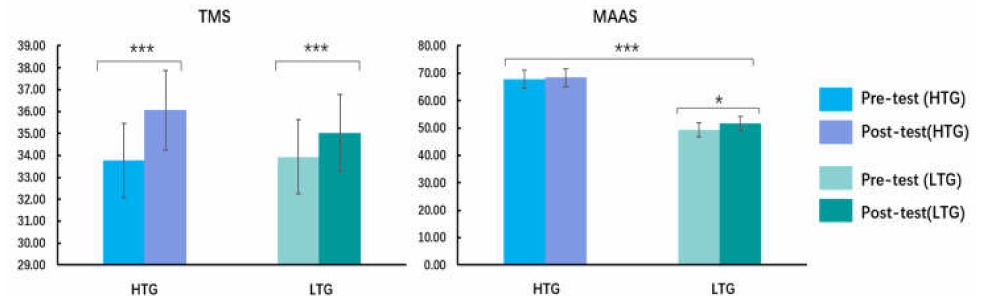
Figure 2. Toronto Mindfulness Scale (TMS) difference within-group and Mindful Attention Aware- ness Scale (MAAS) difference between-group before and after mindfulness meditation training. HTG: high trait group, LTG: low trait group; * p < 0.05, *** p < 0.001. No significant between-group differences in age or sex were found (all p >